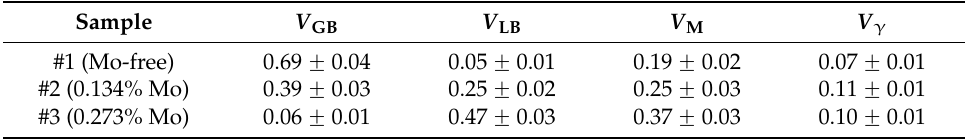
Table 2. Quantitative data on the microstructure of different